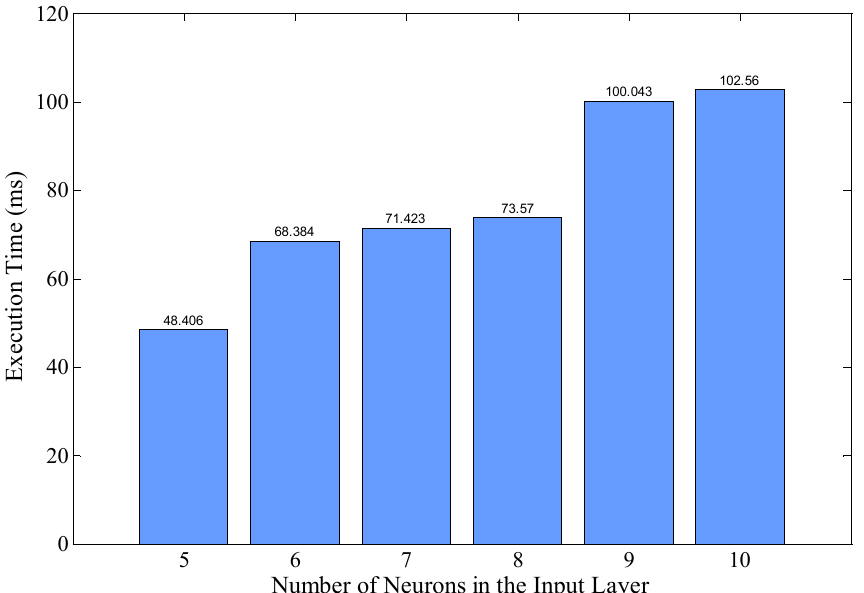
Figure 13. Execution overhead of the proposed method on TelosB.